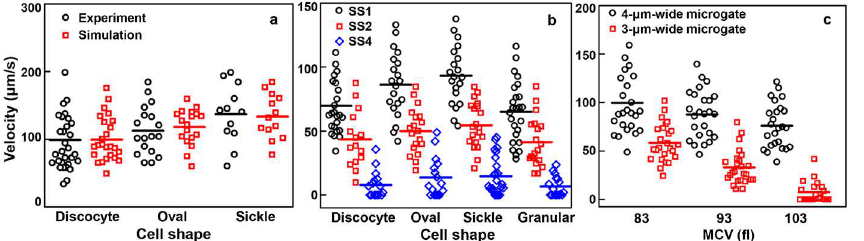
Fig 5. Dependence of cell biodynamics on sickle cell shapes and mean cell volume in the Oxy and DeOxy states. (a) Transit velocity of sickle cells with different shapes in the Oxy state obtainedfrom experiment (black circles) and simulation(red squares). (b) Simulations of transit velocity of sickle cells in fractions I (SS1, black circles), II (SS2, red squares), and IV (SS4, blue diamonds) in the DeOxy state. (c) Simulations of transit velocity of individualsickle RBCs with different cell volume through 4- μ m-wide(black circles) and 3- μ m-wide(red squares)microgates.